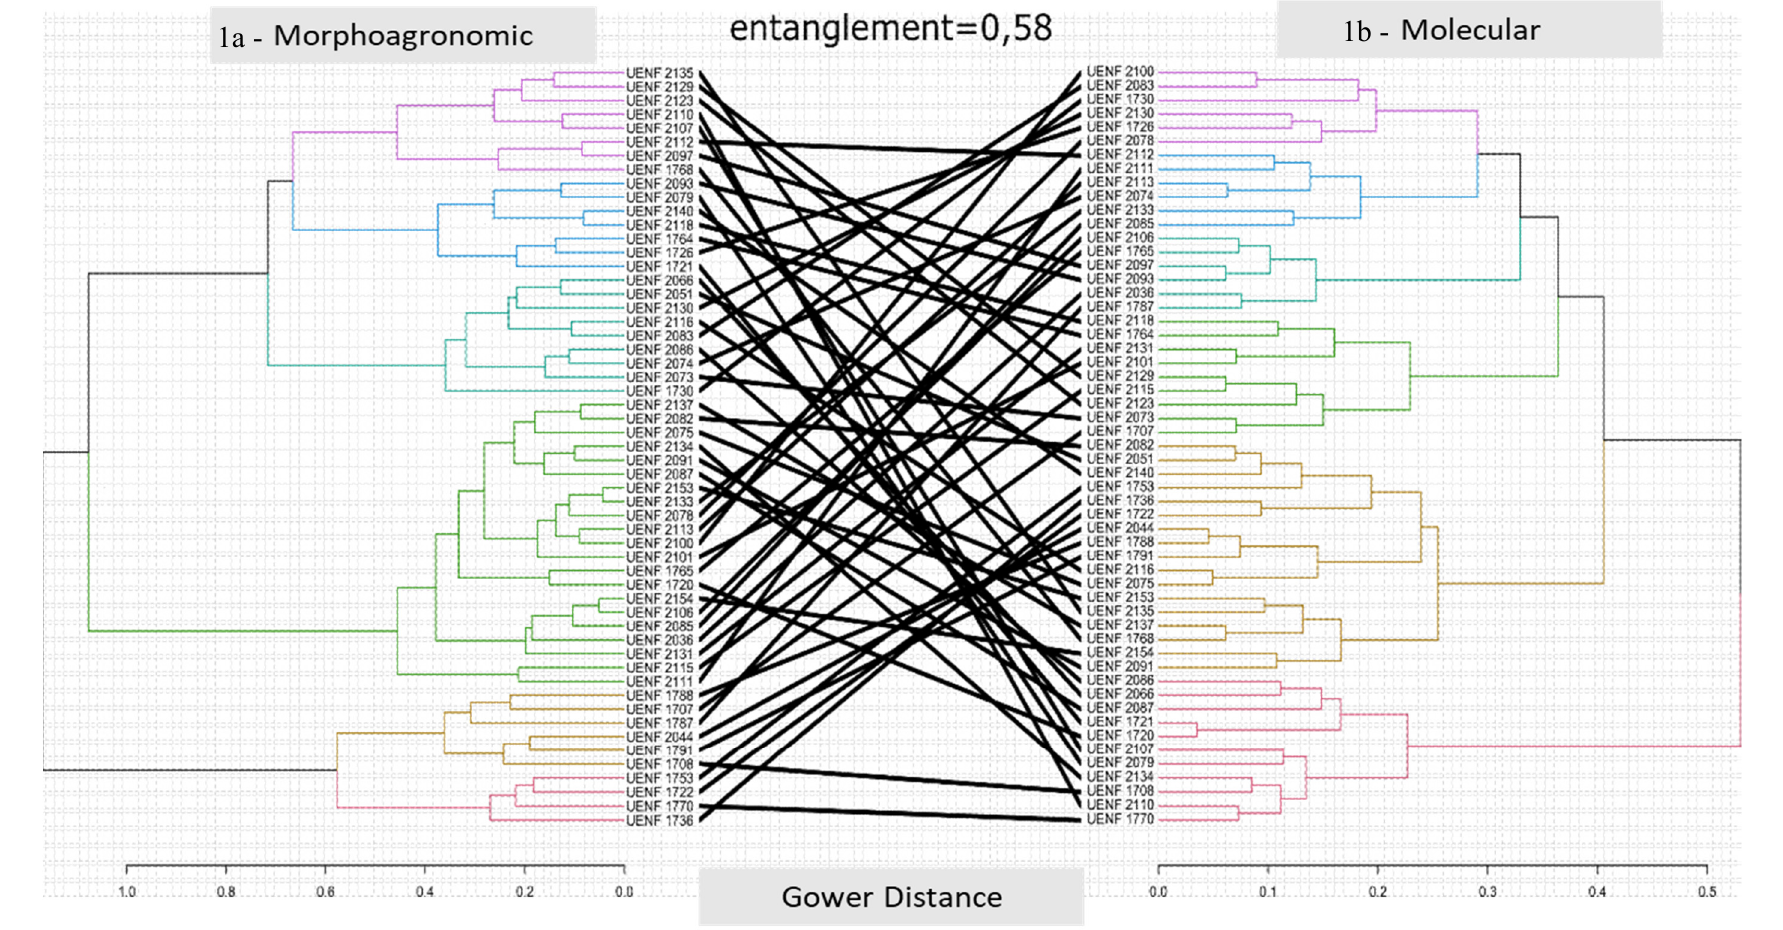
Figure 1. Grouping between 55 accessions of C. chinense , obtained by the Dendextend package, based on Gower Distance. 1a. Morpho-agronomic traits; 1b. Molecular variables.